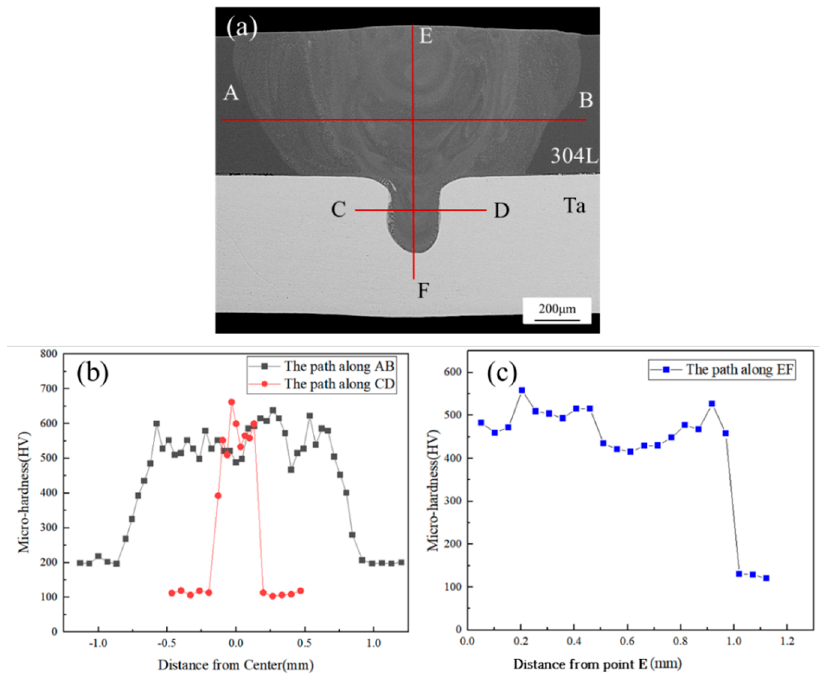
Figure 10. Hardness distribution: ( a ) hardness test path; ( b ) hardness distribution along AB and CD paths; ( c ) hardness distribution along EF path.